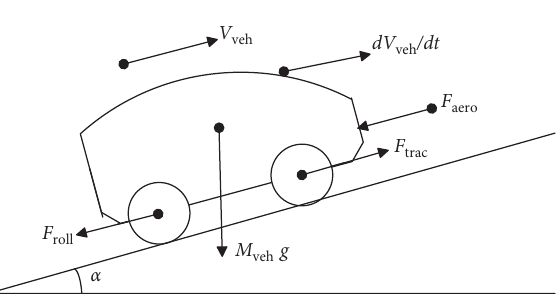
Figure 15: Longitudinal forces on a running